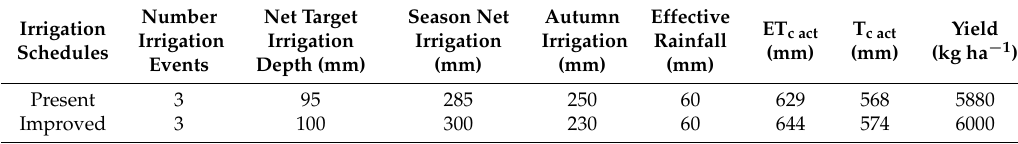
Table 3. Water use components relative to current and improved wheat irrigation schedules (from [16]).